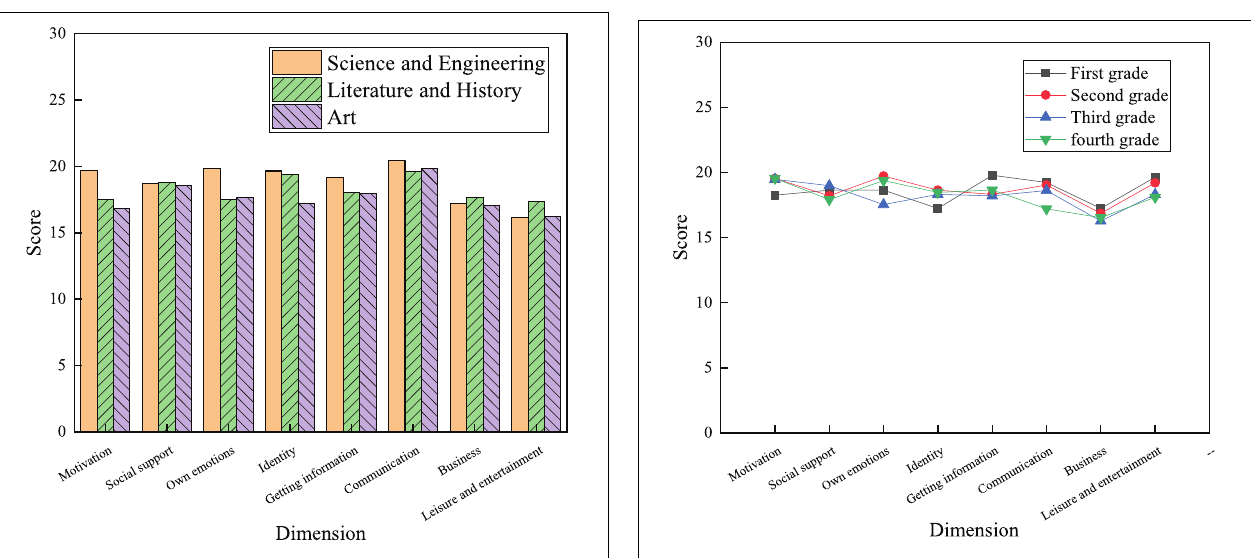
FIGURE 10 | Influences of grades on the use of network buzzwords by college